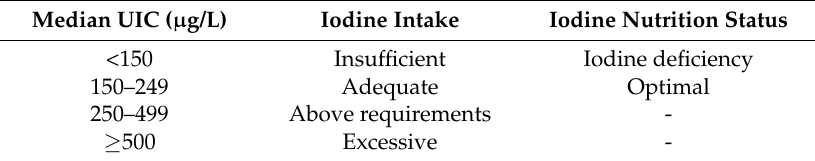
Table 1. Criteria for assessing iodine nutrition status in pregnancy based on median urinary iodine concentration (UIC).